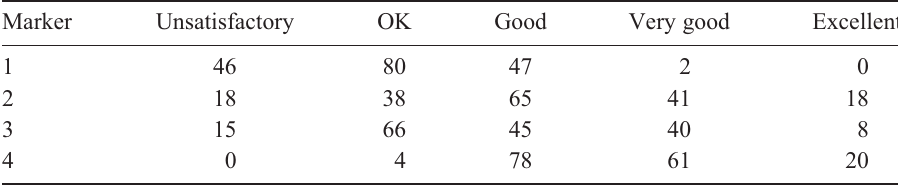
Table 4. Marker trends scoring essay quality characteristics.